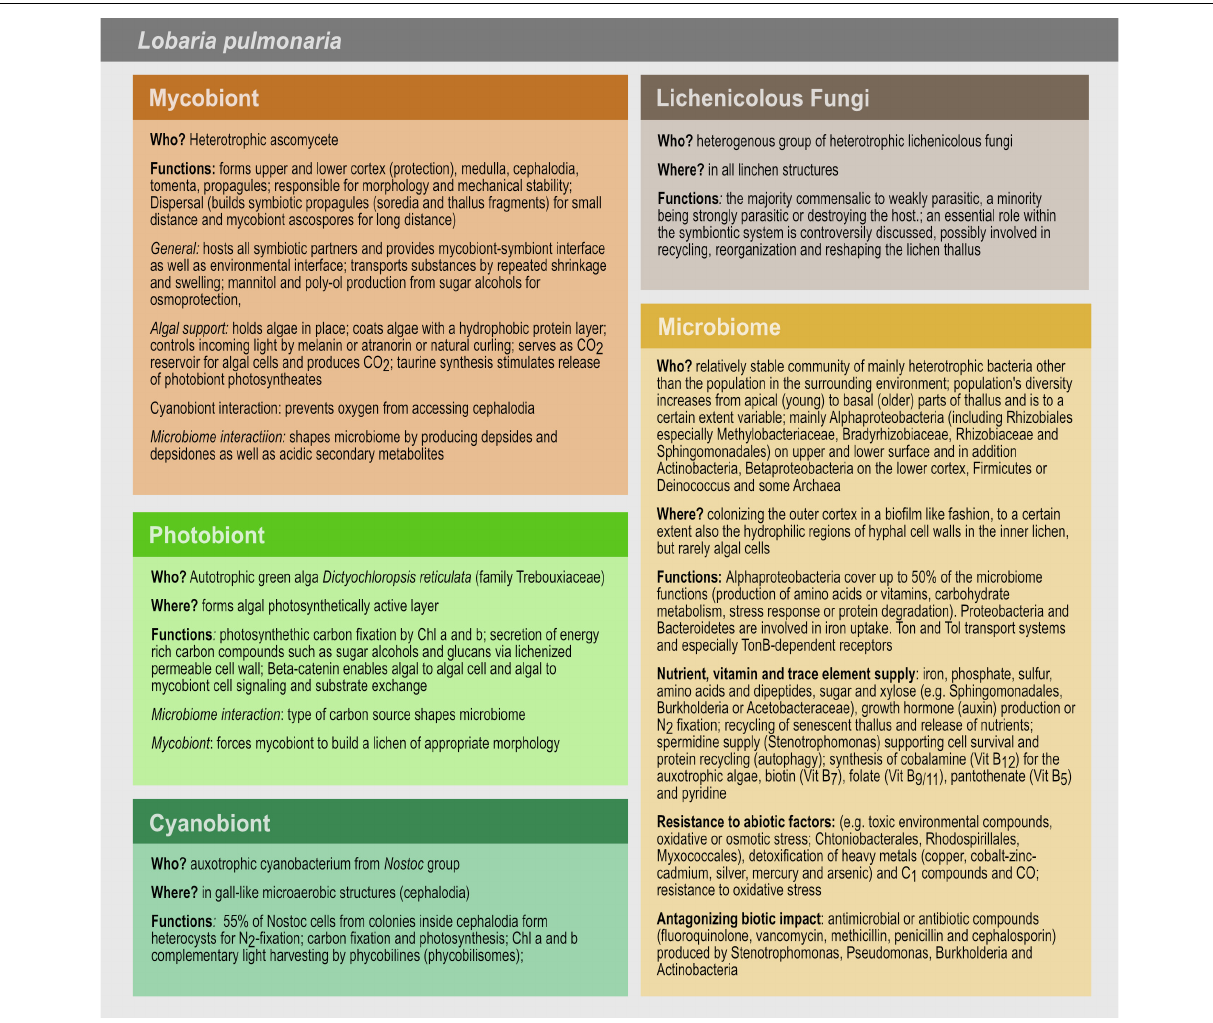
FIGURE 5 | Microbiome and symbiotic partner’s functions in the lichen L. pulmonaria . The mycobiont is responsible for the holobionts’ morphology, mechanical stability and reproduction, protects and supports the photo- and cyanobiont and shapes the microbial community. The photobiont is in charge of the photosynthetic carbon fixation. The cyanobiont is responsible for nitrogen and carbon fixation. The detailed role of the lichenicolous fungi is unclear. The microbiome plays a role in nutrient, vitamin and trace element supply, in resistance to abiotic factors and in antagonizing biotic